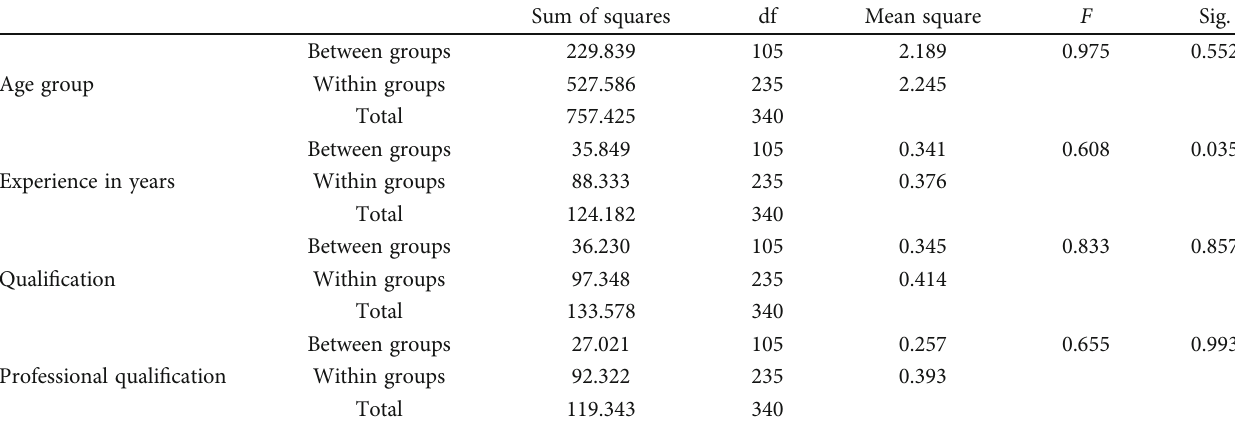
Table 3: ANOVA for ELTs ’ ratings on